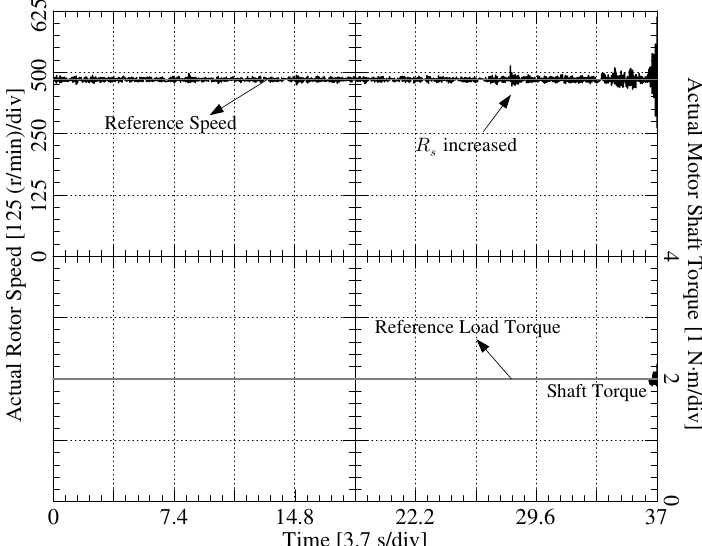
Figure 11. Experimental speed response under full load (2 N·m) with the steady-state 360 r/min speed reference when R s is increased stepwise by 82.35% at t = 28 s with K = 1 (low).